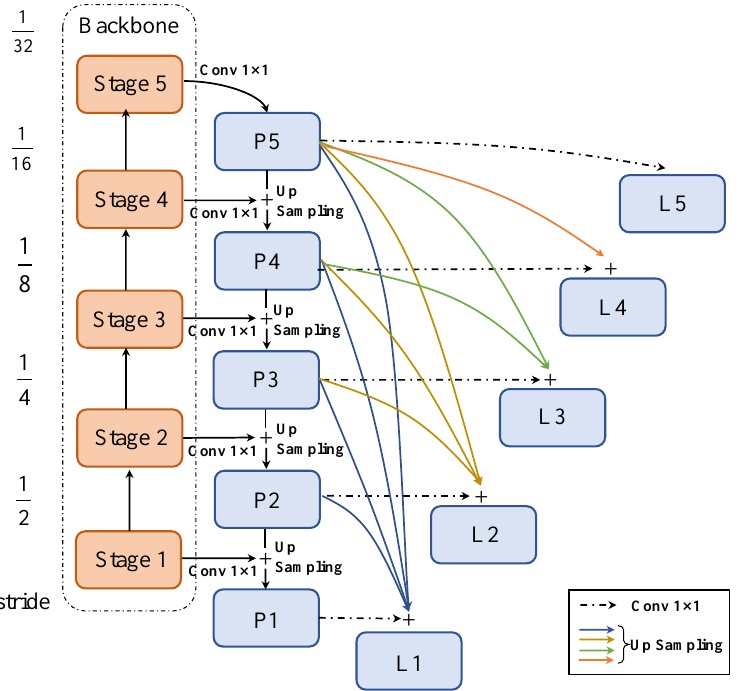
Figure 5. Fine-grained FPN. Compared to a standard FPN module, The fine-grained FPN directly builds the connection from the low-level feature to high-level features and avoids the context infor- mation being